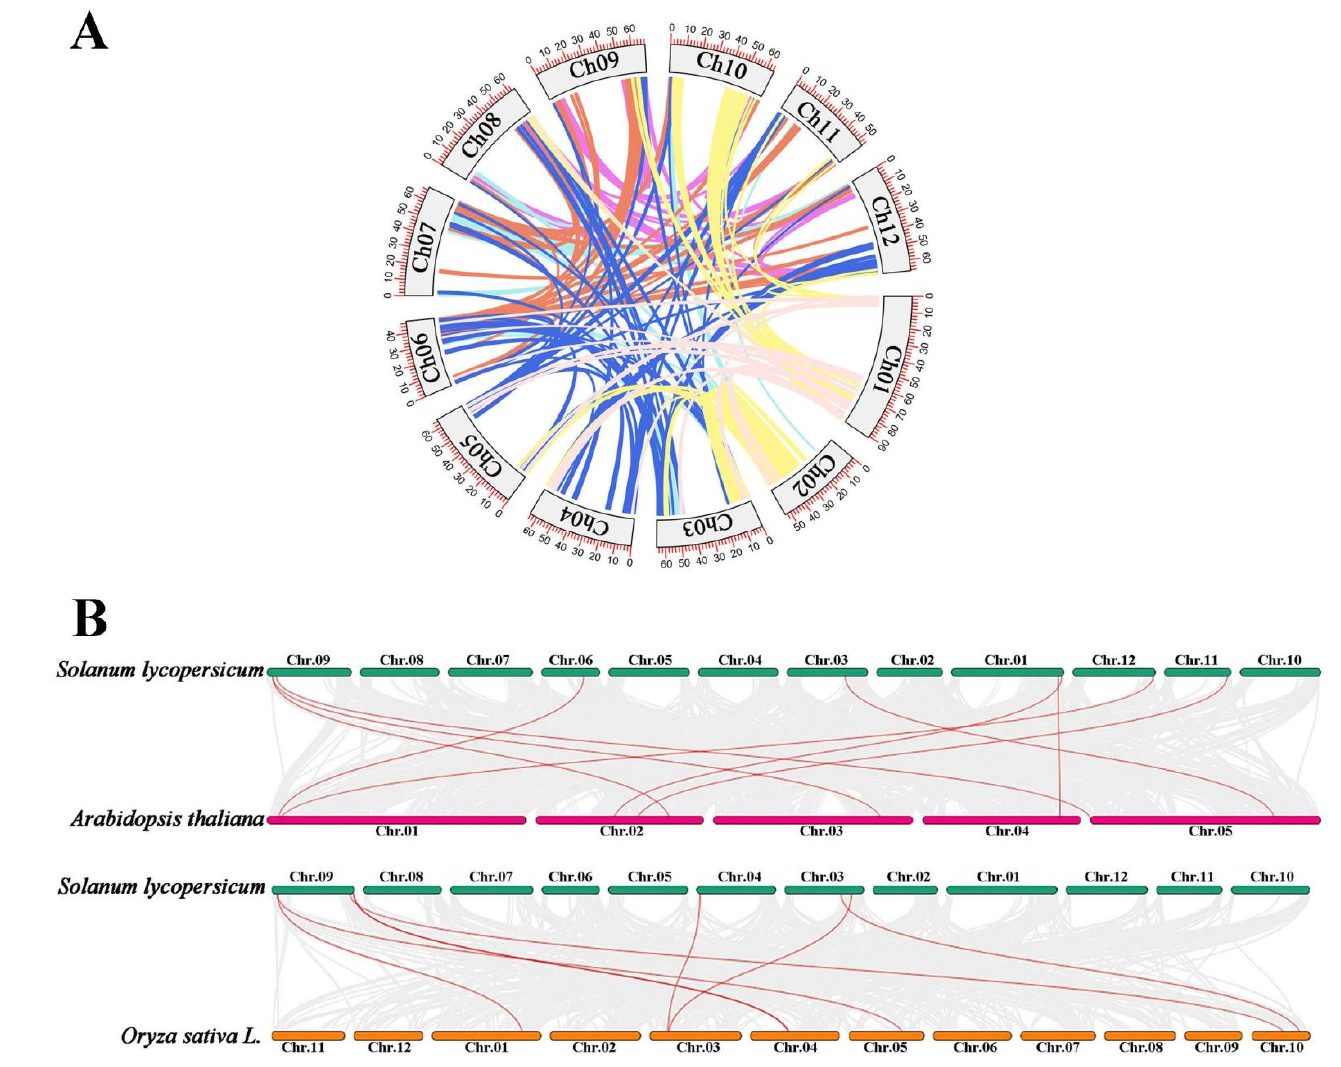
Figure 6. Collinearity relations of AKR in Solanum lycopersicum , Arabidopsis thaliana, and Oryza sativa . ( A ) Collinearity analysis of SlAKR family genes in Solanum lycopersicum ; ( B ) Collinearity analysis of AKR family genes not only between Solanum lycopersicum and Arabidopsis thaliana but also between Solanum lycopersicum and Oryza sativa .